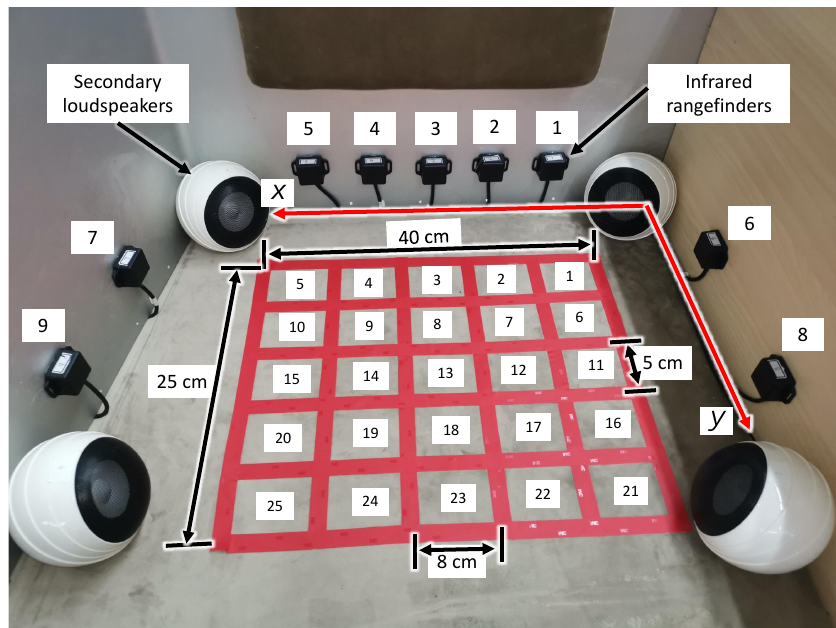
Figure 2. Schematic diagram of the head-tracking